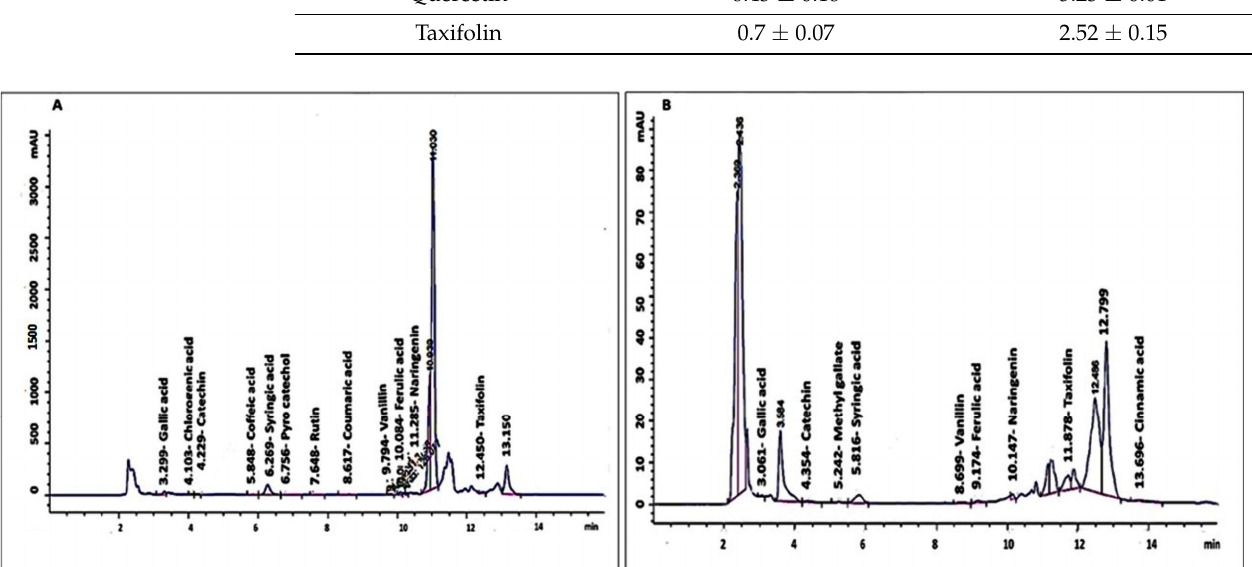
Figure 1. HPLC chromatography results show peaks of flavonoid contents of isolated PCIBP and EPCIBP. ( A ) PCIBP; ( B ) EPCIBP.